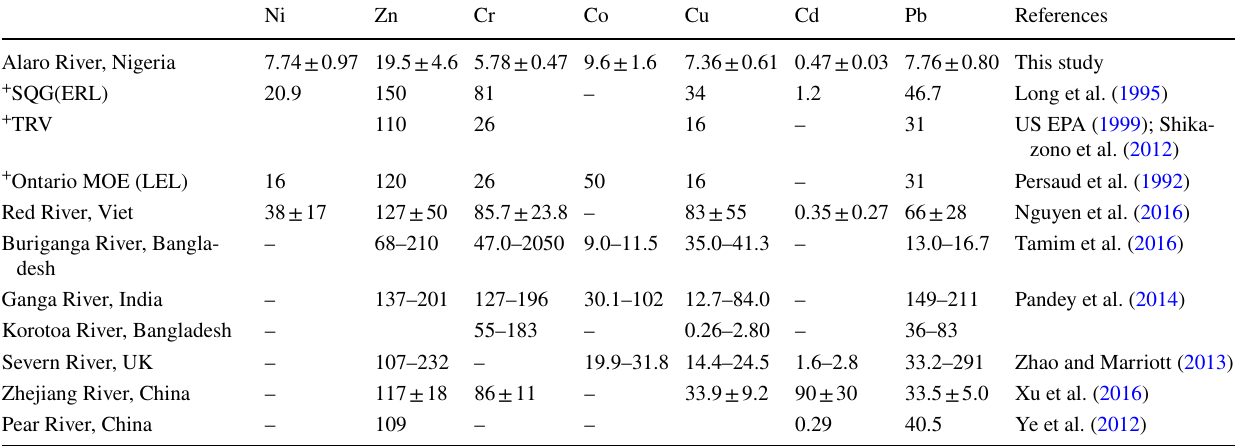
Table 3 Comparison of metal concentrations of Alaro River sediment with the sediment quality standards (+) and other studies